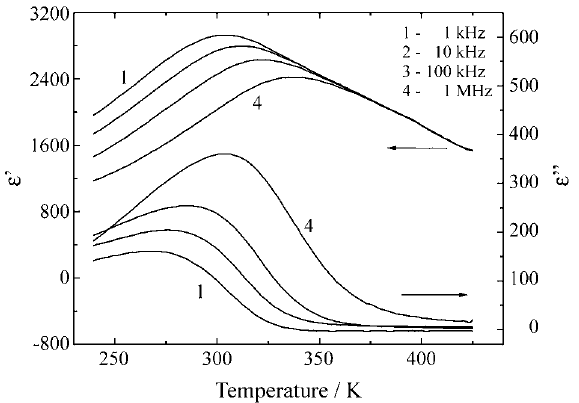
Figure 1. Dielectric constant ( ε ’) and dielectric absorption ( ε ’’) measured as a function of temperature and frequency for SBN (Ref.